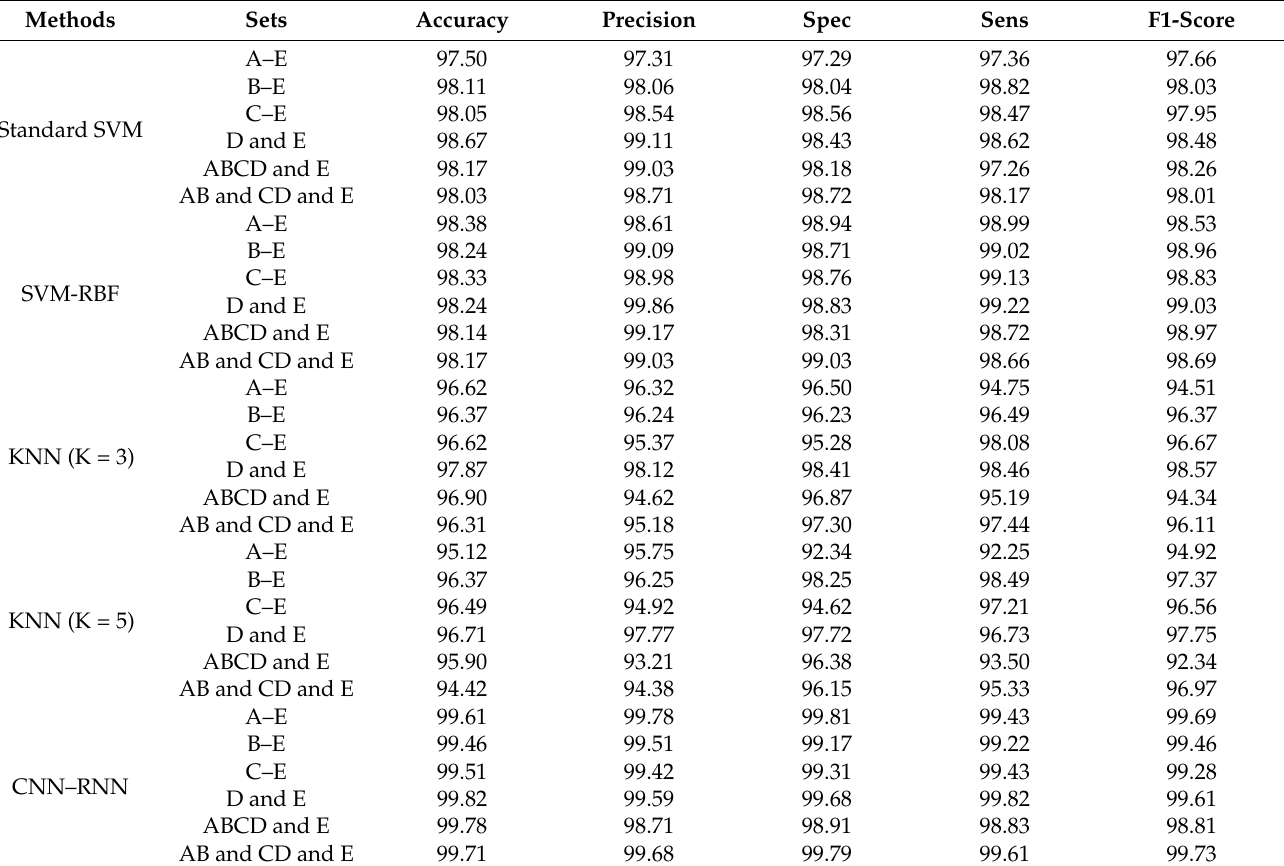
Table 6. Results for the Bonn dataset.